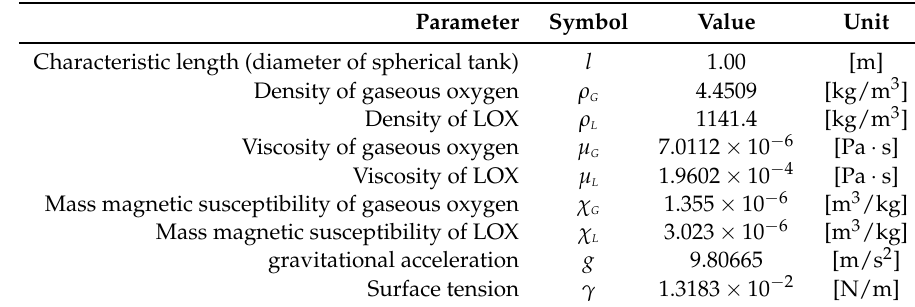
Table 2. Physical property values.